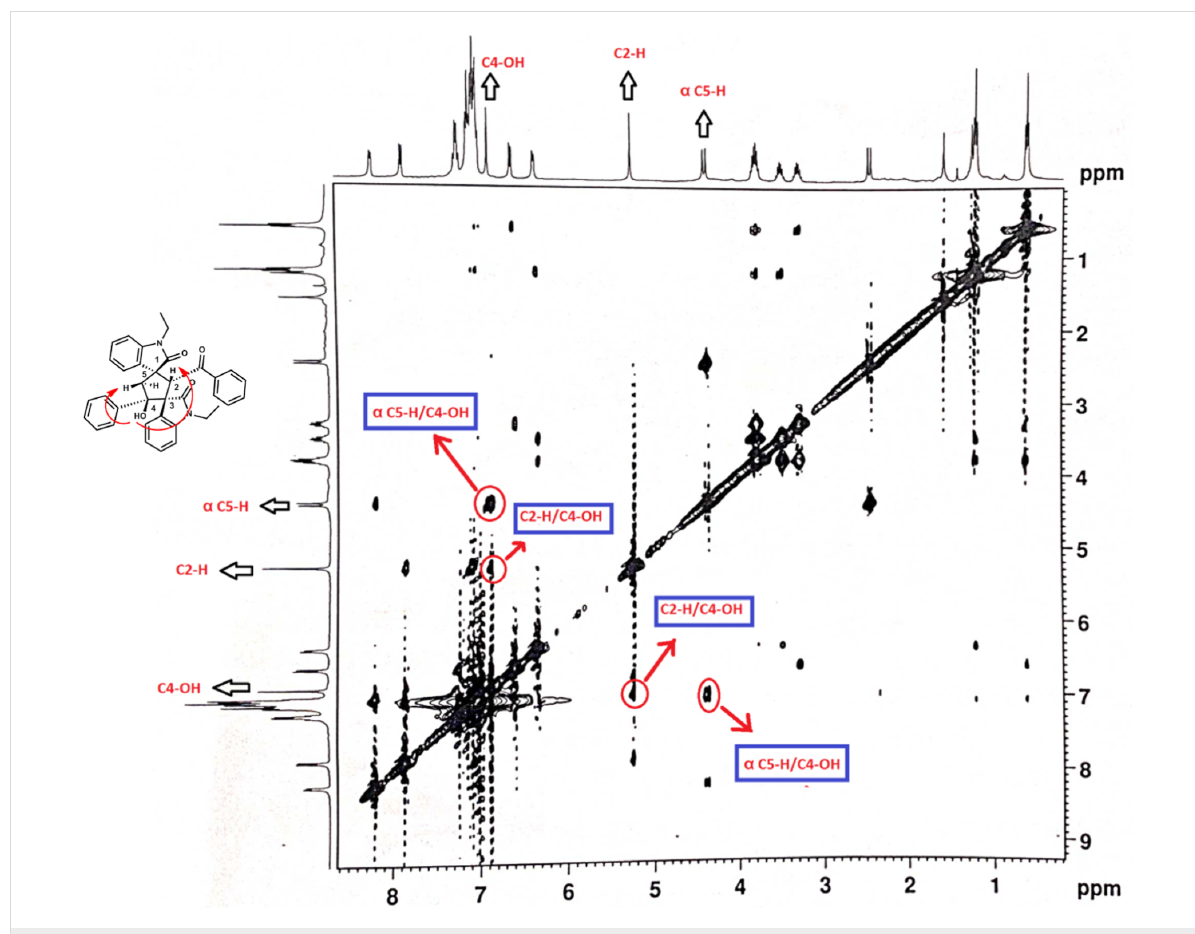
Figure 3: NOESY Spectra of compound 3e .